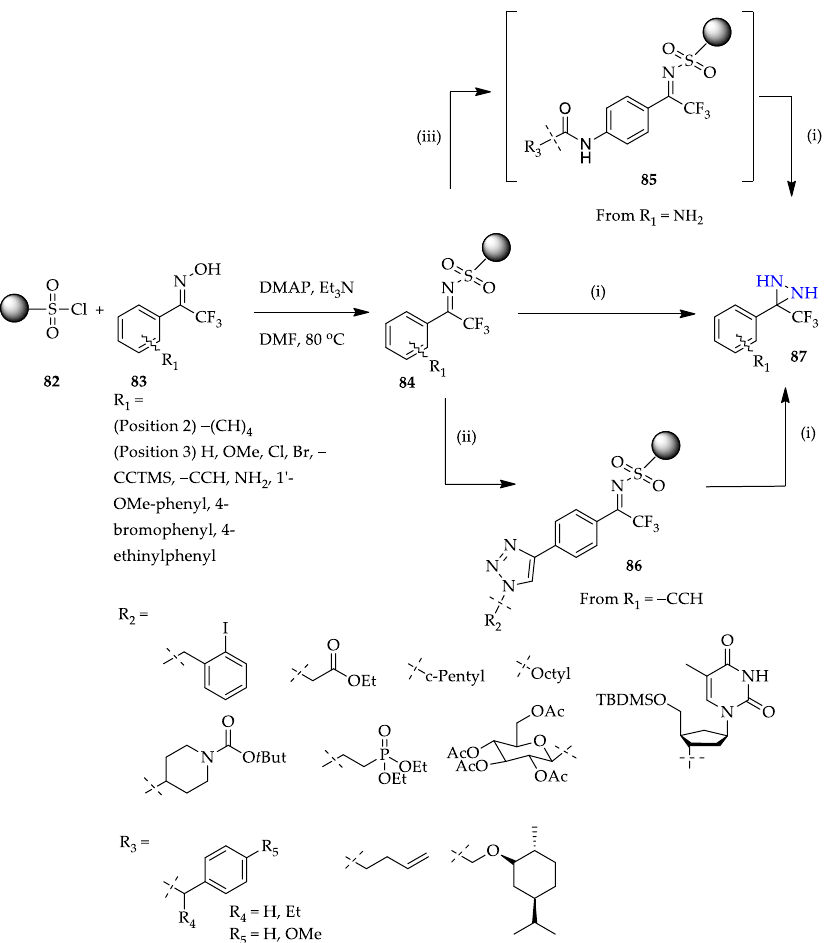
Figure 11. Synthesis of diaziridines 87 via unconventional resin-bound sulfonyl oxime 82 reagent. Reagents: (i) NH 3 -dioxane; (ii) R 2 -N 3 , CuI, DIPEA, DMF, H 2 O; (iii) R 3 -COCl, Et 3 N or R 3 -CO 2 H, DIC, HOBt.